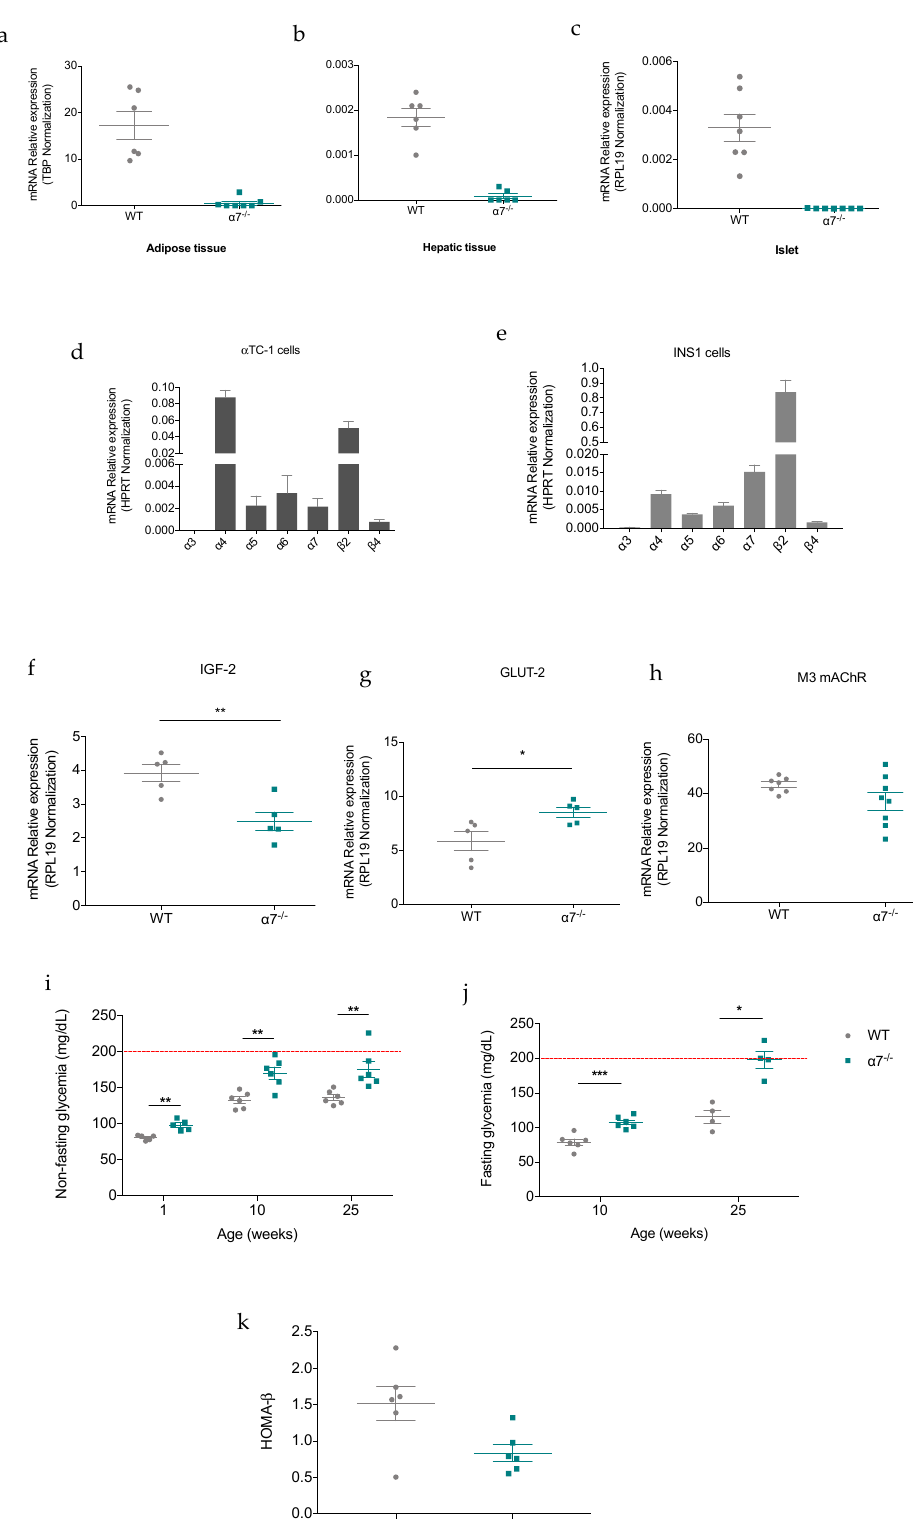
Figure 1. The constitutive lack of α 7 nAChR induces a mild hyperglycemic state in male mice fed standard chow diet. mRNA expression of the α 7 nicotinic subunit was measured in visceral adipose ( a ) and hepatic ( b ) tissues, and pancreatic islets ( c ). Gene expression levels were normalized to